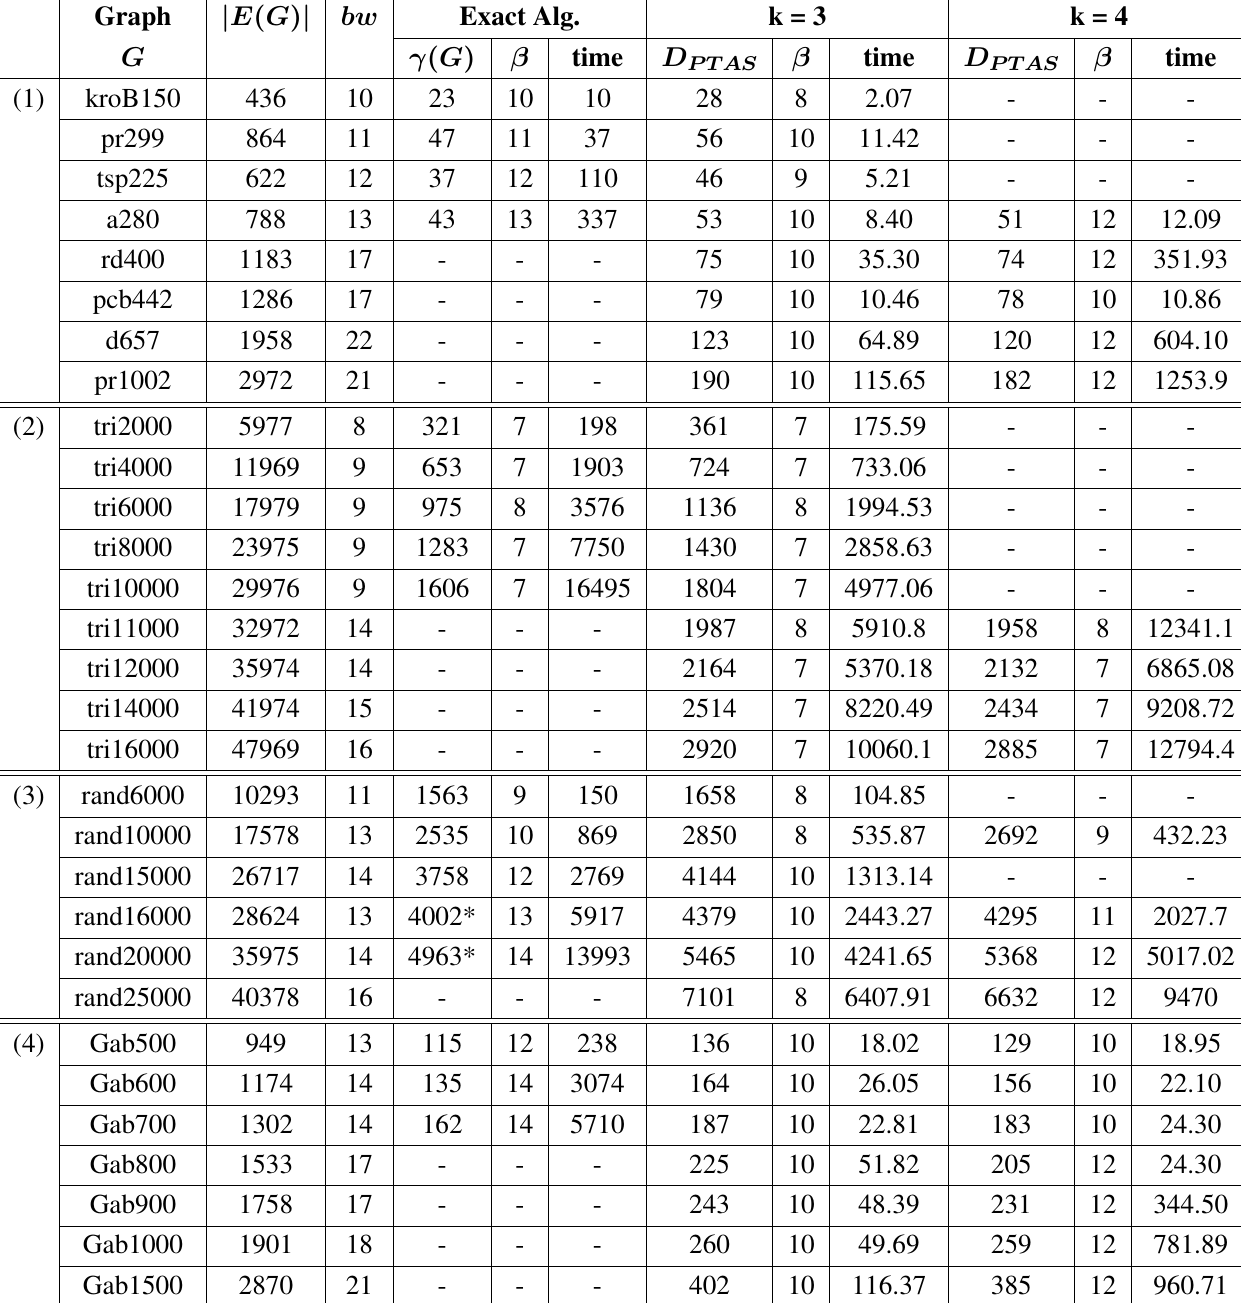
Table 1. Computational results (time in seconds) of PTAS for the planar dominating set